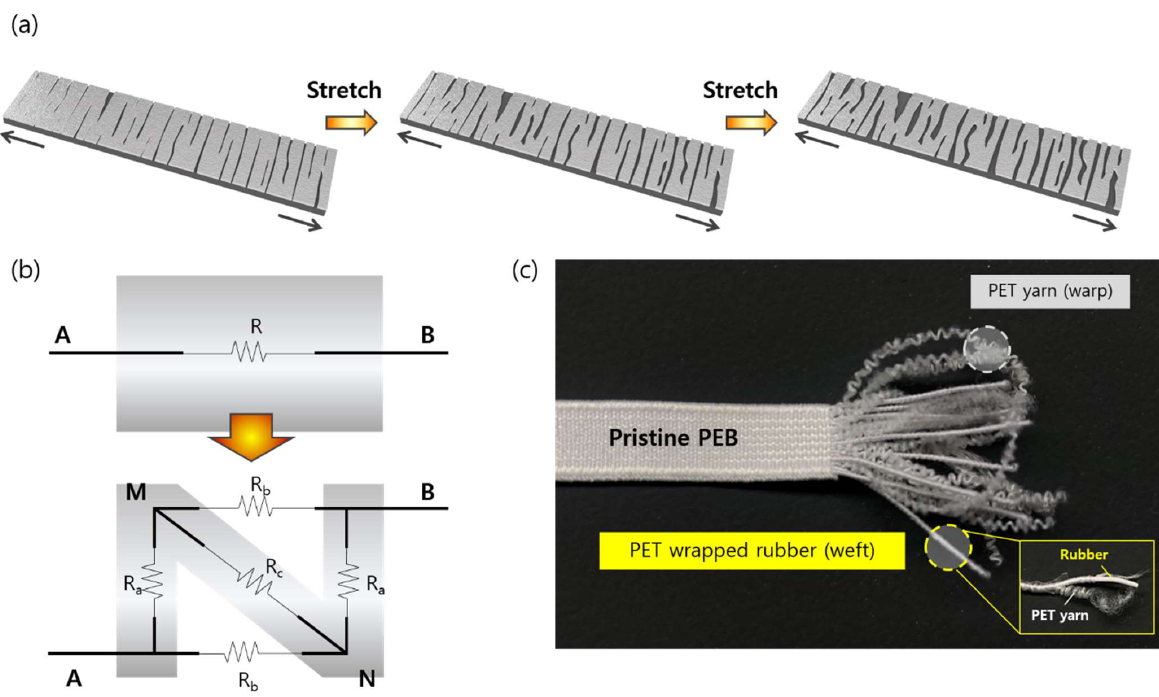
Figure 4. ( a ) Strain sensing mechanism of the pre-cracked strain sensor: the dark gray layer represents PEB dipped into SWCNT inks; the light gray layer shows the silver coating on SWCNT/PEB; ( b ) Resistance model of the crack structure; ( c ) Fabric structure of the polyester woven elastic band utilized in the present study.